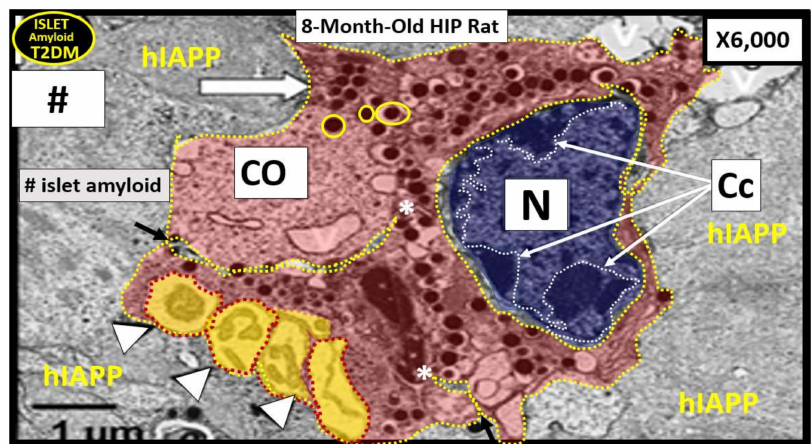
Figure 16. Pancreatic islet β -cell apoptosis in the HIP rat model of T2DM. This representative pseudo-colorizedpancreaticislet β -cellinthepreclinical8-month-oldHIPratdiabeticmodel(Figure10D) depicts apoptosis characterized by β -cell atrophy, nuclear chromatin condensation (Cc with white arrows), loss of cytoplasmic organelles (CO), cytoplasmic vacuole formation and apoptotic bodies (arrowheads). Note how islet amyloid may insert into β -cells (arrows and asterisks). β -cell apoptosis in MetS, T2DM and COVID-19 may be due to a combination of a virus virion storm (SARS-CoV-2), redox storm and cytokine storm as they converge and interact with the multiple metabolic toxicities of MetS and prediabetes or overt T2DM, which may result in injury and a response to the injury wound healing mechanism within the islet and its microcirculation and encourage the acceleration of T2DM due to early dysfunction and later loss of β -cells via apoptosis. Nucleus (blue); cytoplasm (red); apoptotic bodies (yellow); extracellular matrix—hashtag islet amyloid (concrete grey color). CO = cytoplasmic organelles; hashtag = islet amyloid; hIAAP = human islet amyloid polypeptide; ISG = electron dense insulin secretory granules (open arrow and encircled by yellow lines of both immature haloed and more mature unhaloed